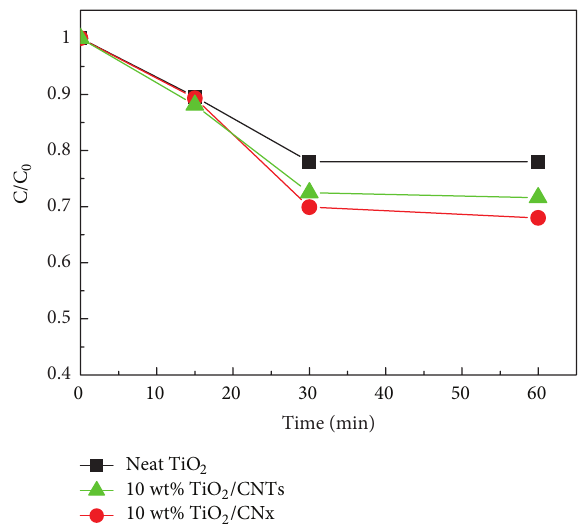
Figure 6: Influence of adsorption time on the remaining fraction of MO (C/C 0 ) by neat TiO 2 , 10wt% TiO 2 -CNTs composites, and 10wt% TiO 2 -CNx composites.